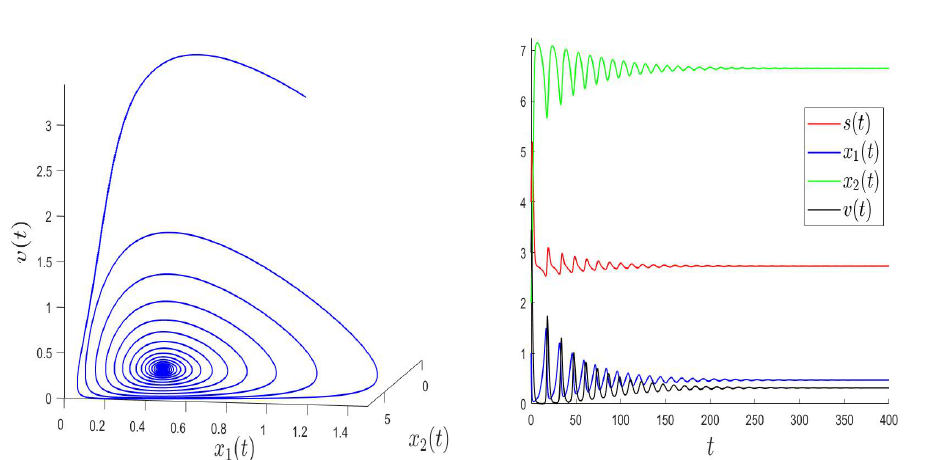
Figure 5. D = 0.9375, D 1 = 2.5, D 2 = 1.875, D 3 = 1.25, D 4 = 0.703, D 5 = 1.96, D 6 = 16.3265, ¯ s 1 = 1.83673, ¯ s 2 = 2.72727, ¯ s = 11.3066. Assumption 1 is satisfied, and the solution of the system (2) , where the two species coexist. converges to the positive equilibrium E 1,2 1